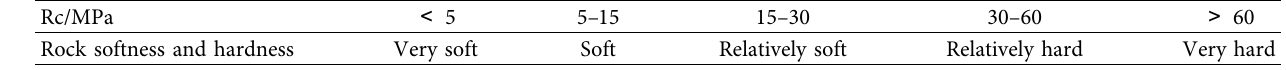
Table 1: Rock uniaxial compressive strength and soft and hard